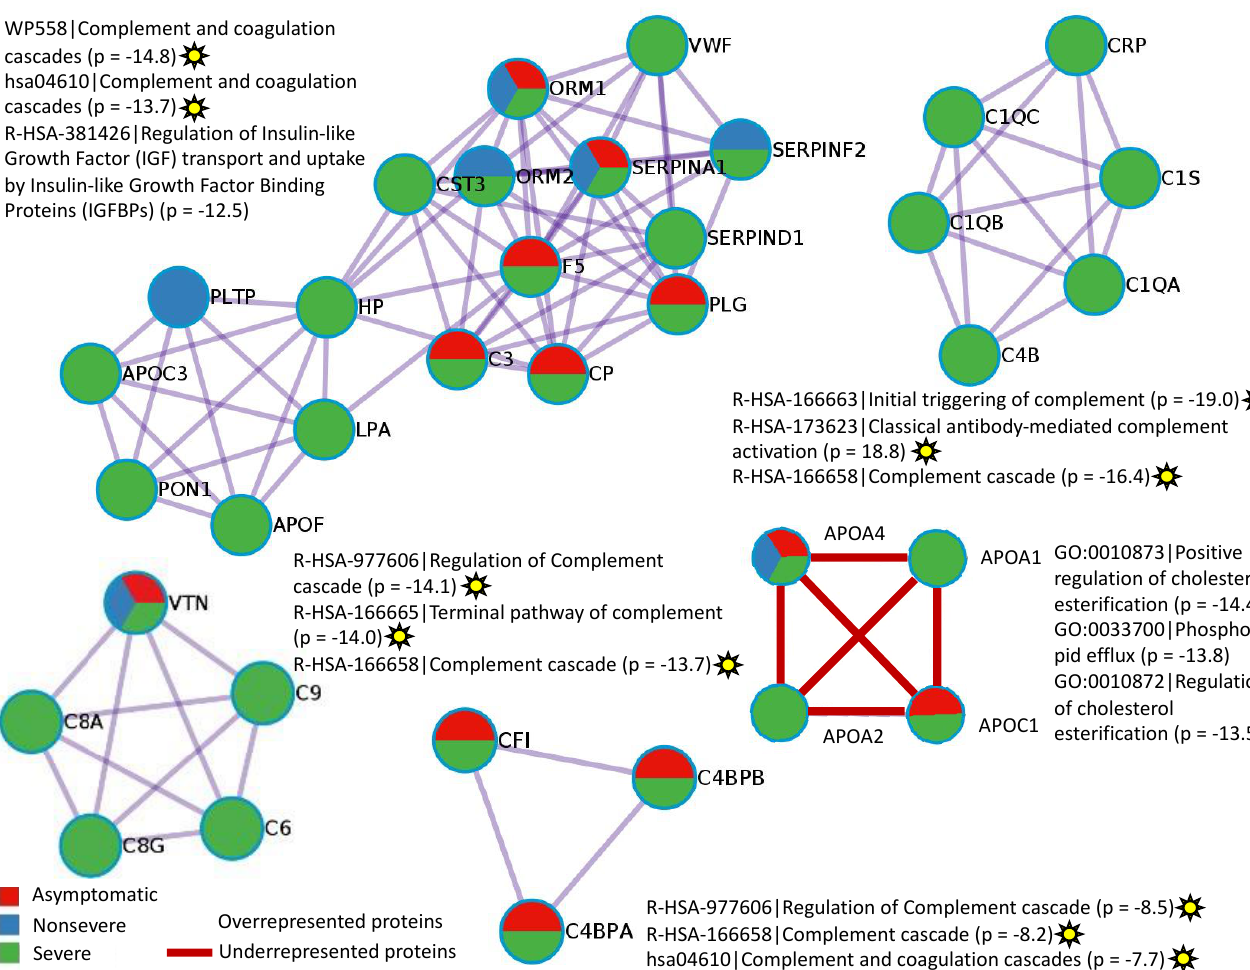
Figure 7. Protein–protein-interaction networks and components for non-Ig proteins over- and underrepresented in infected cohorts when compared to PCR– cases. The MCODE algorithm was applied to networks to identify neighborhoods where proteins are densely connected. GO enrichment analysis was applied to the original protein–protein-interaction network and its MCODE network components to extract their “biological meanings,” where the top three best p -value terms were retained. GOs with proteins involved in the regulation of complement and coagulation cascades and antibody-mediated complement activation are identified with yellow stars.